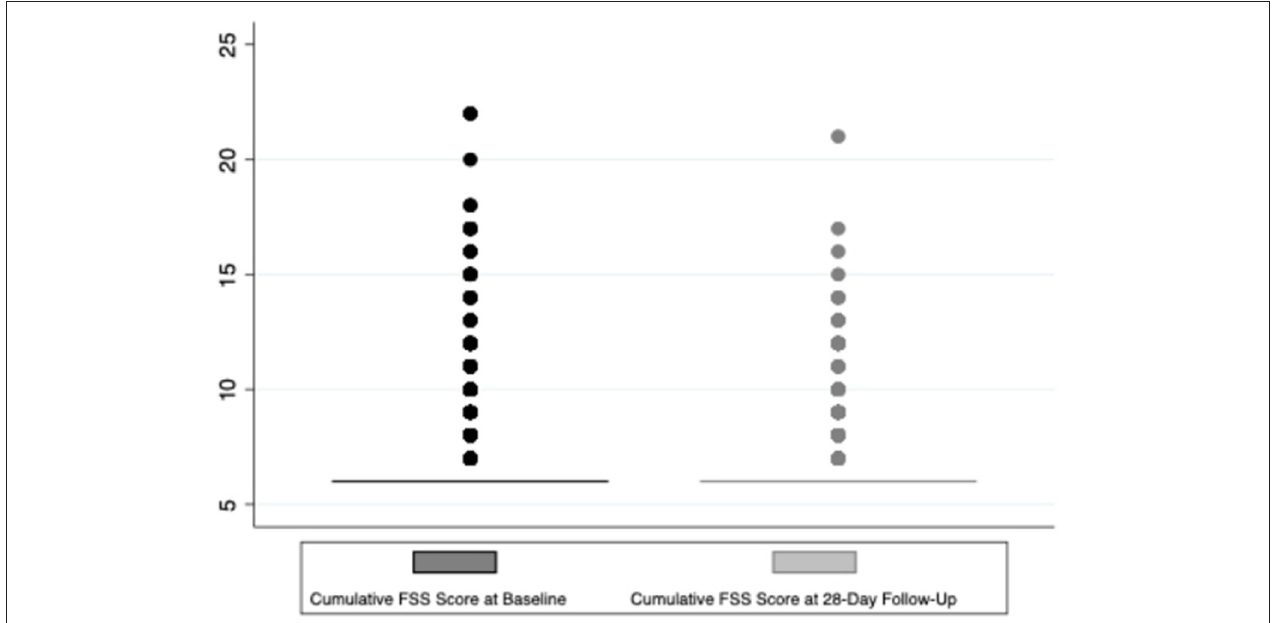
FIGURE 4 | Box plot of baseline cumulative FSS score and 28-day follow-up FSS score.